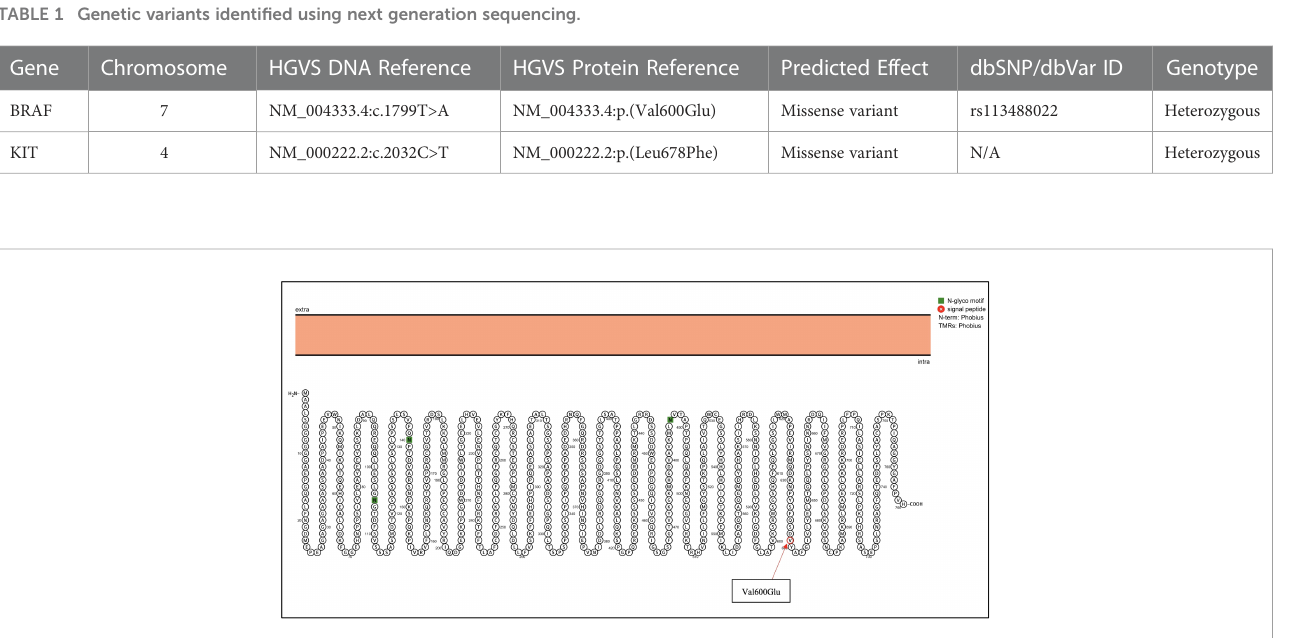
FIGURE 2 BRAF genetic mutation identi fi ed in the patient by NGS. Proteins were visualized with Protter (12). The red circle highlights the identi fi ed Val600Glu mutation in the BRAF